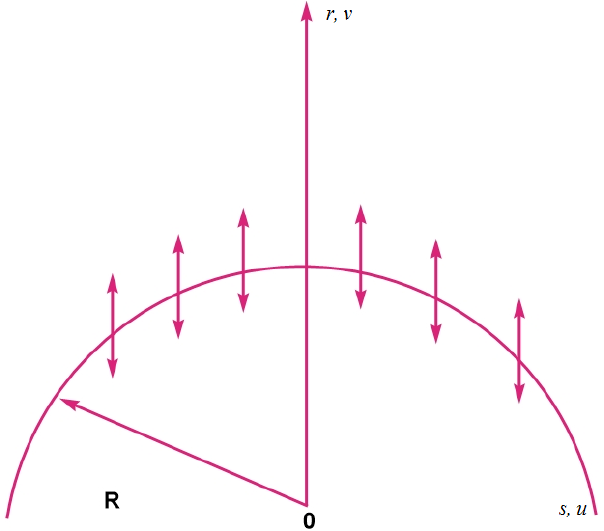
Figure 1. Flow Figure 1. Flow geometry.